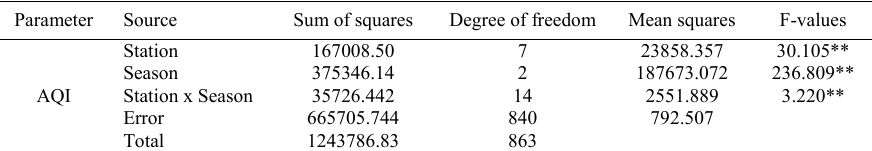
Table 8: Two-way ANOVA test for AQI based on stations and seasons Parameter